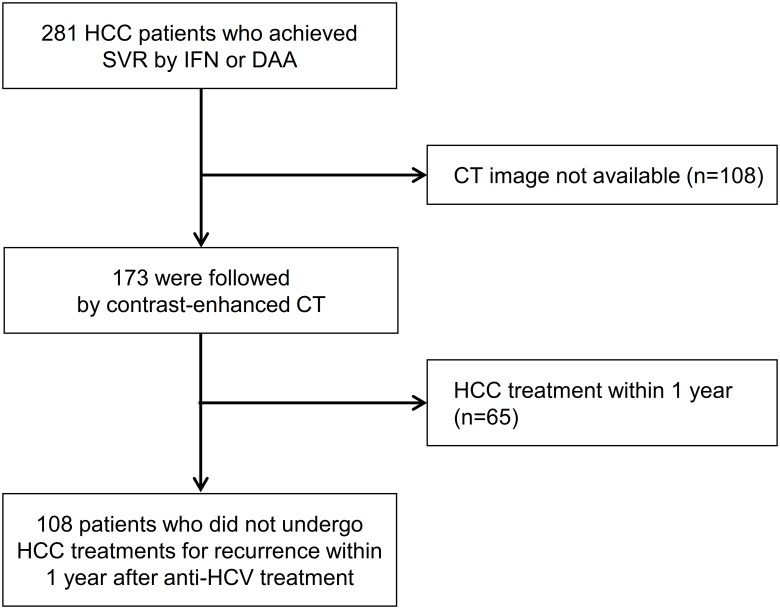
Patient flow diagram.CT, computed tomography; DAA, direct-acting antiviral; HCC, hepatocellular carcinoma; HCV, hepatitis C virus; IFN, interferon; SVR, sustained virologic response.